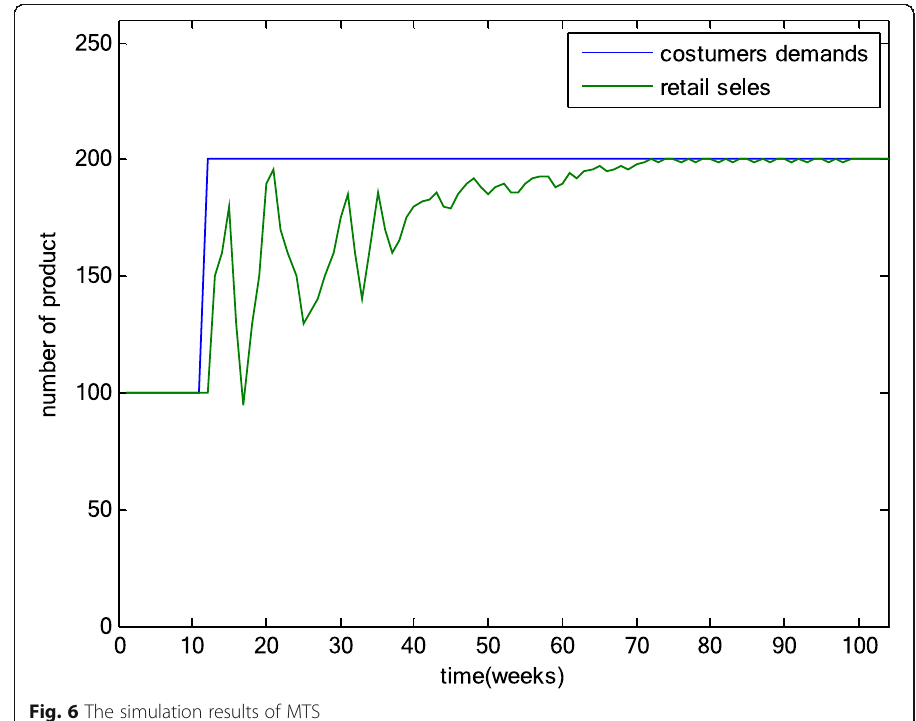
Fig. 6 The simulation results of MTS